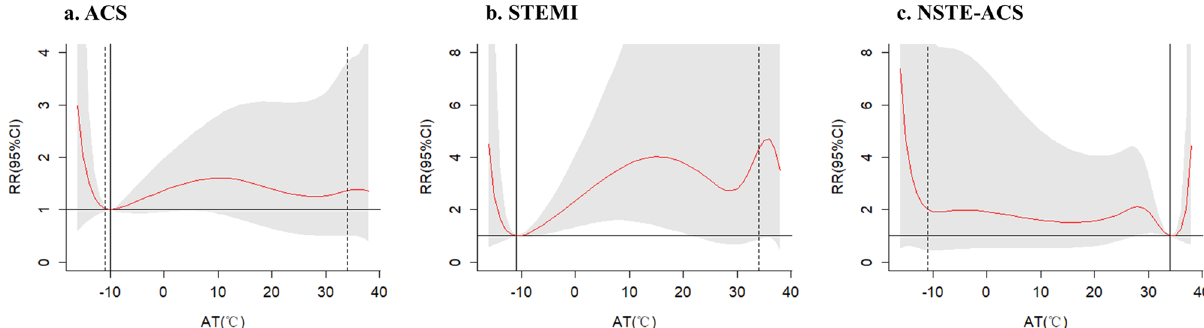
Figure 3. Exposure–response relationship between apparent temperature (AT) and daily hospital admissions due to acute coronary syndrome (ACS) in disease-specific groups (with reference of the Minimum Admission Apparent Temperature, MAAT). Abbreviations: ACS, acute coronary syndrome; STEMI, ST-segment-elevated myocardial infarction; NSTE-ACS, Non-STEMI acute coronary syndrome. Notes: MAAT for ACS, STEMI and NSTE-ACS was − 10 °C, − 11 °C and 34 °C,